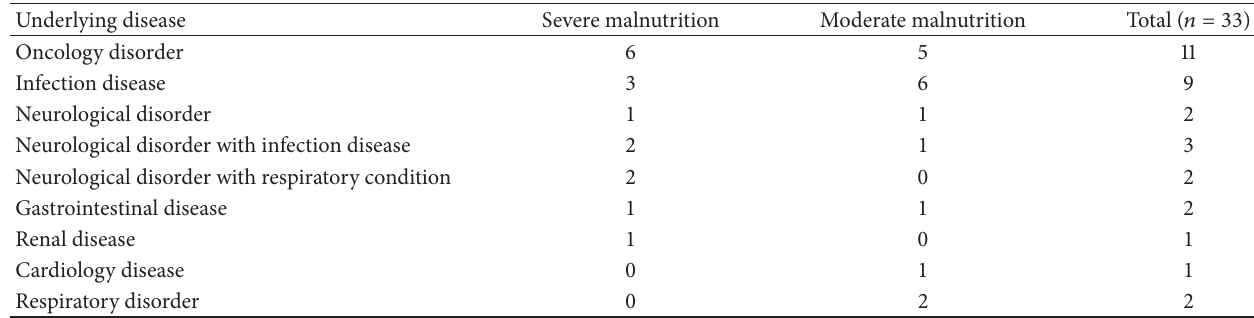
Table 2: Malnutrition prevalence based on the underlying disease.